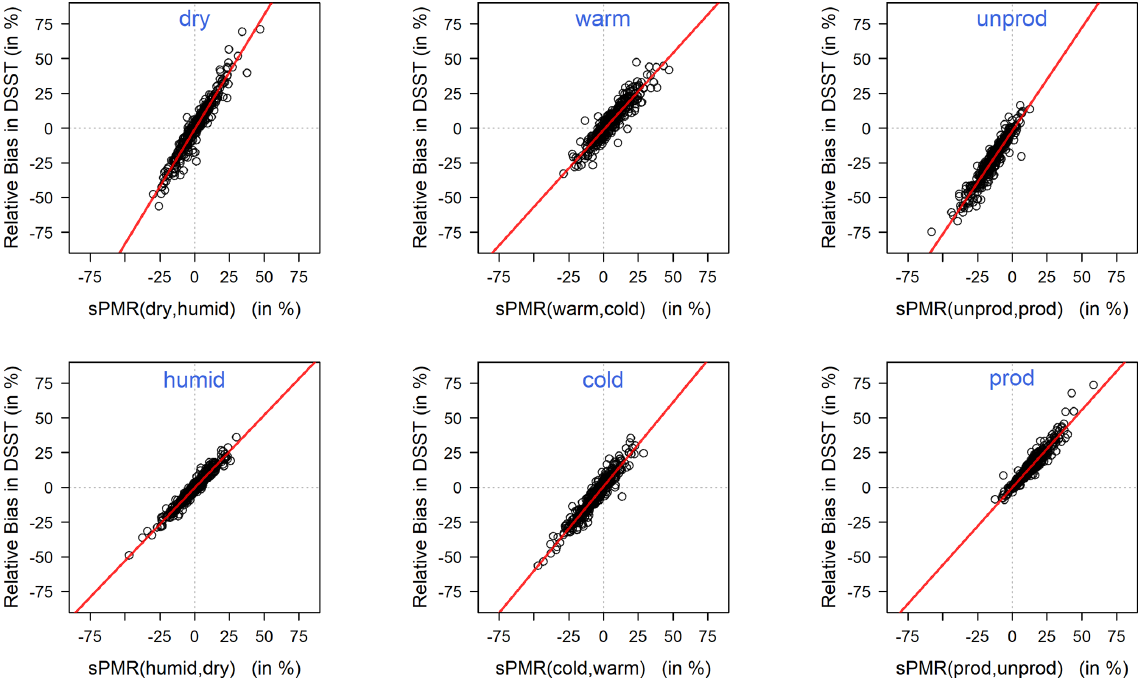
Figure 8. Catchment-wise sPMR values against catchment-wise DSST relative bias (one point per catchment) for each DSST setup. The red line corresponds to the fitted linear model relating DSST relative bias to sPMR for each DSST